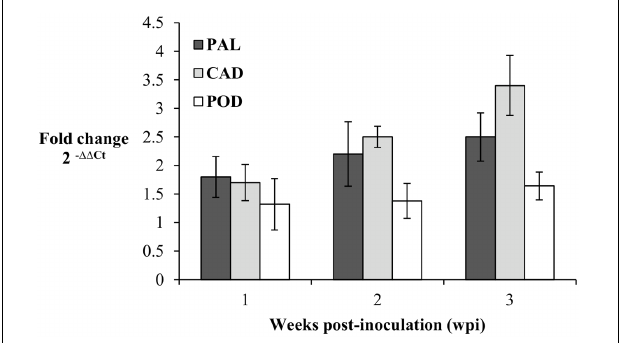
FIGURE 5 | Expression pattern of PAL, CAD, and POD genes in Ganoderma boninense infected oil palm seedlings at 1, 2, and 3 wpi. Fold change (FC) values are computed relative to control (non-inoculated) seedlings. Bars represent mean ± standard error of four biological